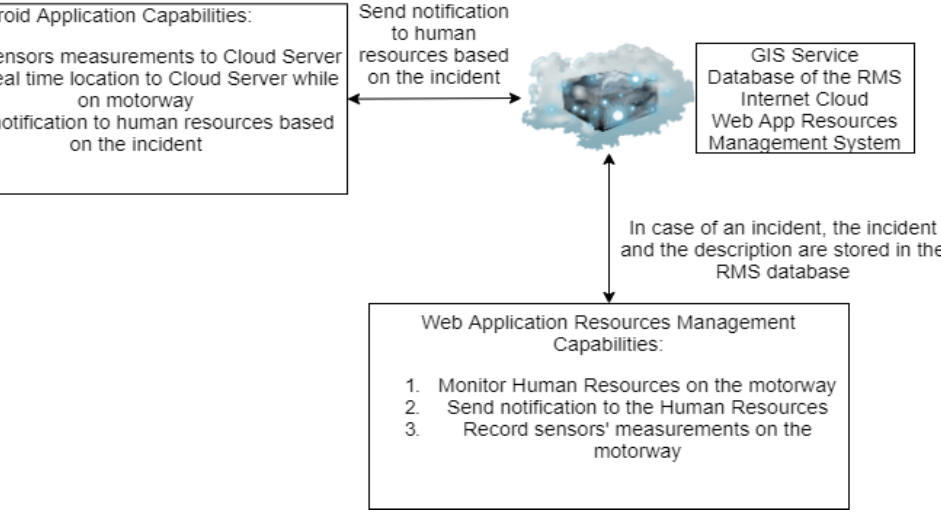
Figure 1. Proposed resource management system architecture.